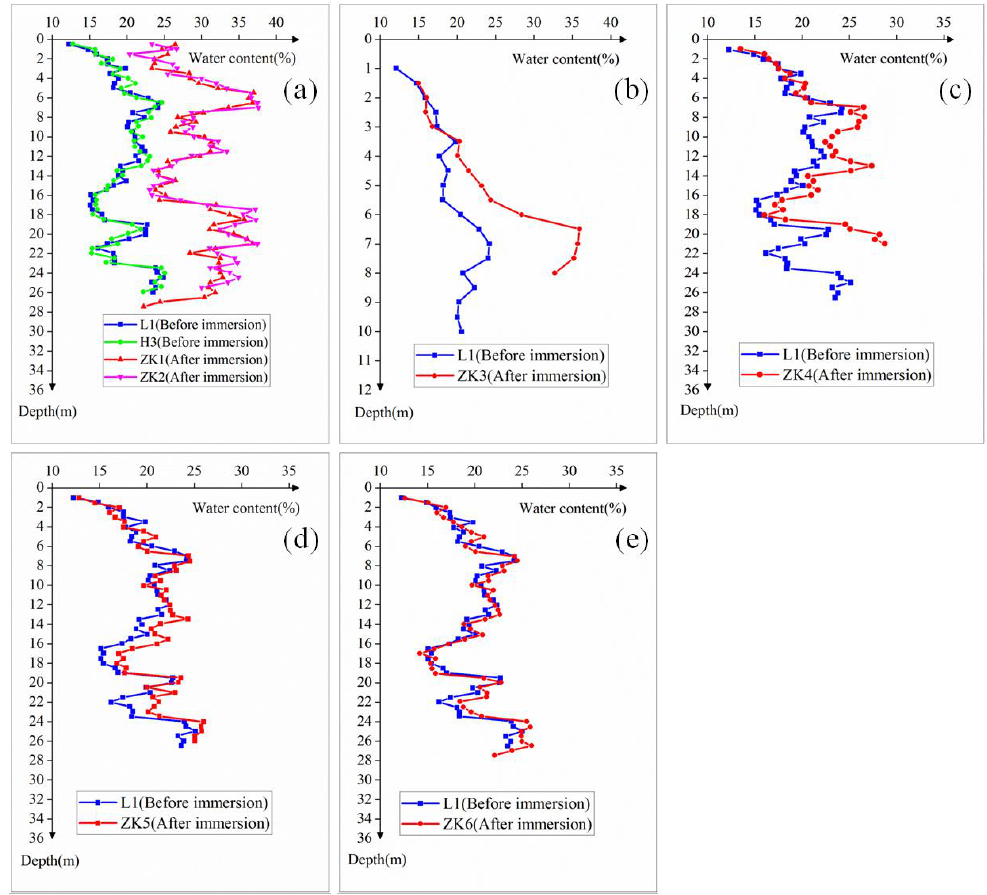
Figure 13. Comparison of water content before and after water immersion, ( a ) in the test pit, ( b ) 3 m from the edge of the pit, ( c ) 6 m from the edge of the pit, ( d ) 9 m from the edge of the pit, and ( e ) 12 m from the edge of the pit.